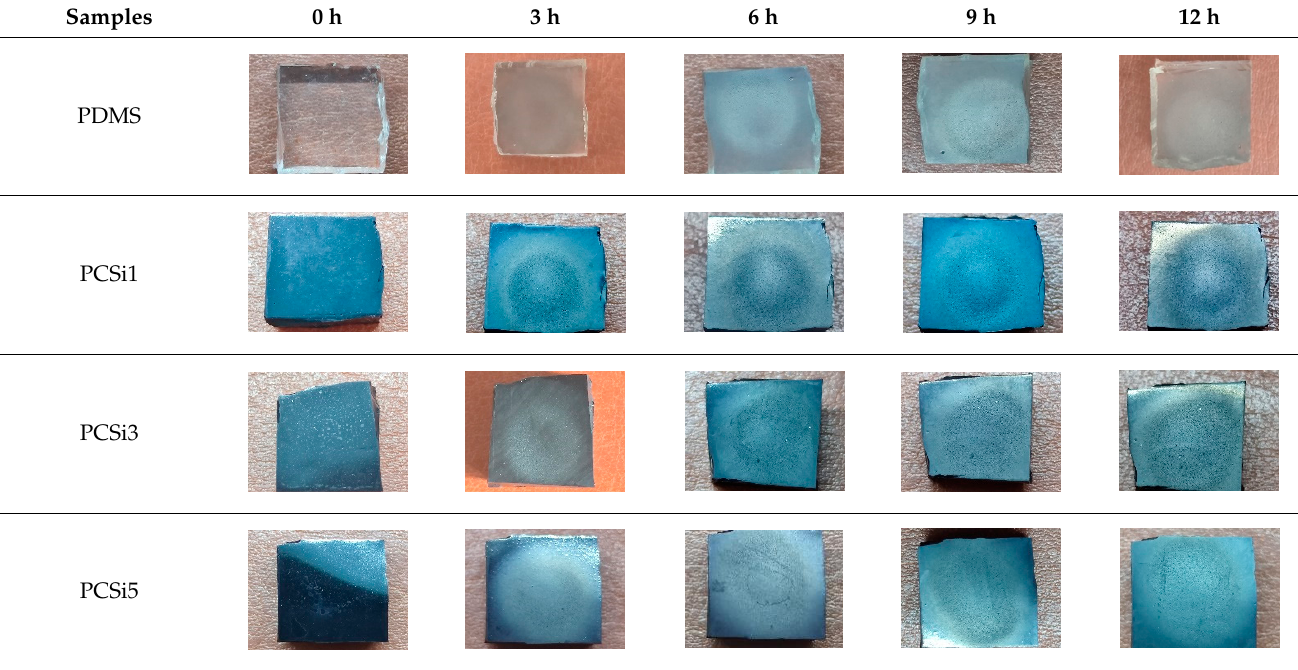
Table 3. Surface images after water erosion.